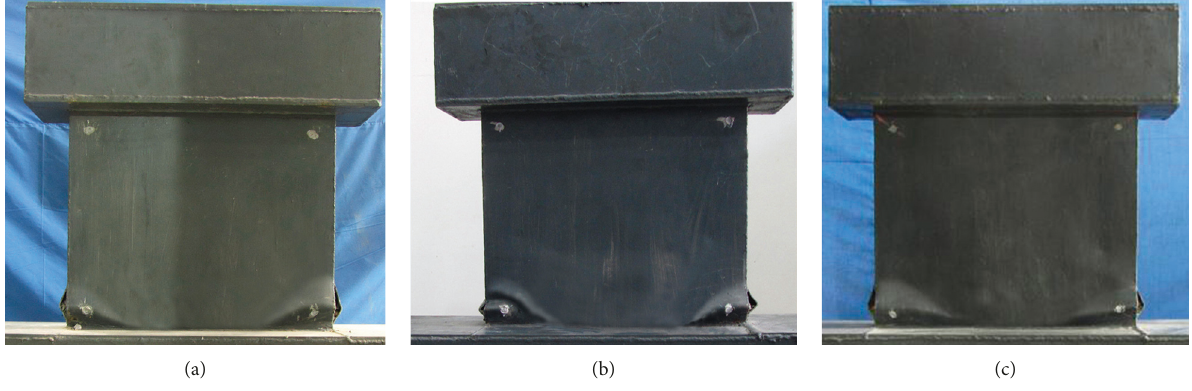
Figure 5: Failure model. (a) DSCW-1. (b) DSCW-2. (c) DSCW-3.